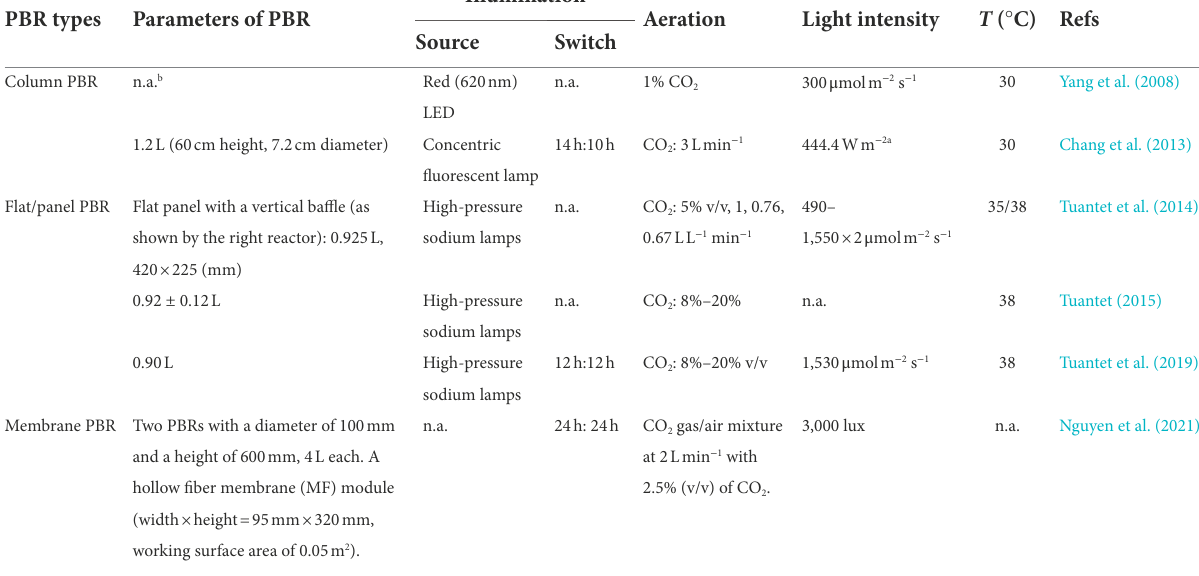
TABLE 2 Summary of photobioreactors (PBR) and operating parameters for biomass culture in